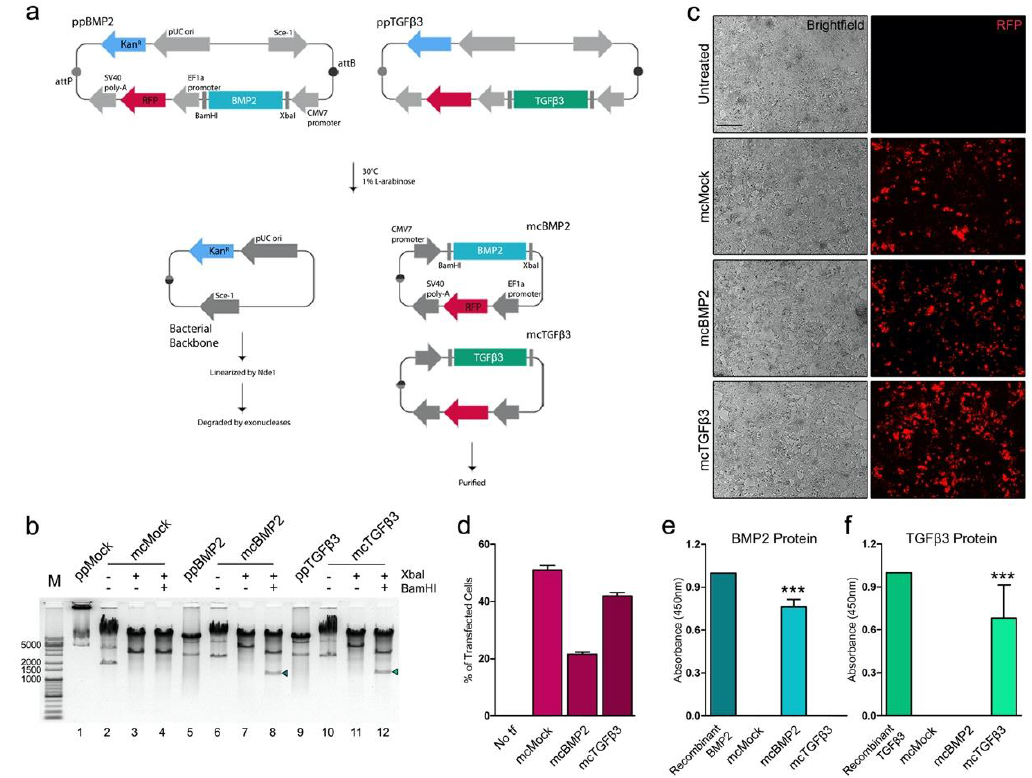
Figure 1. Generation of BMP2- and TGF β 3-encoding minicircles. ( a ) Scheme of minicircle generation process. ( b ) Gel electrophoresis of parental plasmid vectors (pp) and minicircle vectors (mc). The insert (arrow) of mcBMP2 has a size of 1194 bp and mcTGF β 3 has a size of 1236 bp. ( c ) Fluorescence microscopy image of transfected HEK293T cells. ( d ) Percentage of transfected HEK293T cells. ( e ) BMP2 protein expression in mcBMP2-transfected HEK293T sup. ( f ) TGF β 3 protein expression in mcTGF β 3-transfected HEK293T sup. Data presented as mean ± standard deviation from three independent sets of experiments. The scale bar represents 200 µ m. *** p < 0.001 vs. mcMock indicates statistical significance. ppMock: parental mock vector; mcMock: minicircle mock vector; ppBMP2: parental BMP2-encoding vector; mcBMP2: minicircle BMP2-encoding vector; ppTGF β 3: parental TGF β 3-encoding vector; mcTGF β 3: minicircle TGF β 3-encoding vector; tf: